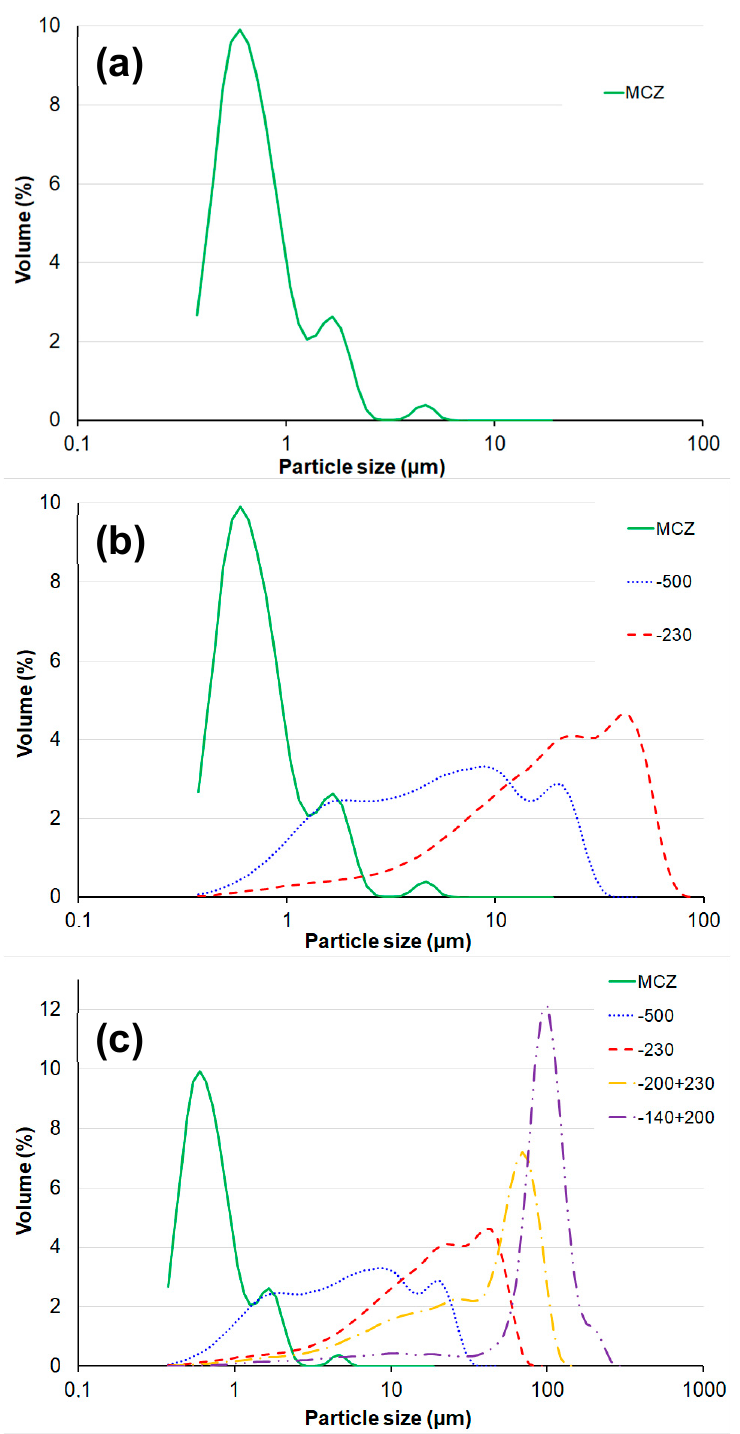
Figure 1. PSD of the ingredient’s classes used in the three composites. ( a ) CZM; ( b ) CZM-2A: CZM and alumina classes of − 500 and − 230 mesh; ( c ) CZM-4A: CZM and alumina classes of − 500, − 230, − 200 + 230 and − 140 + 200 mesh.